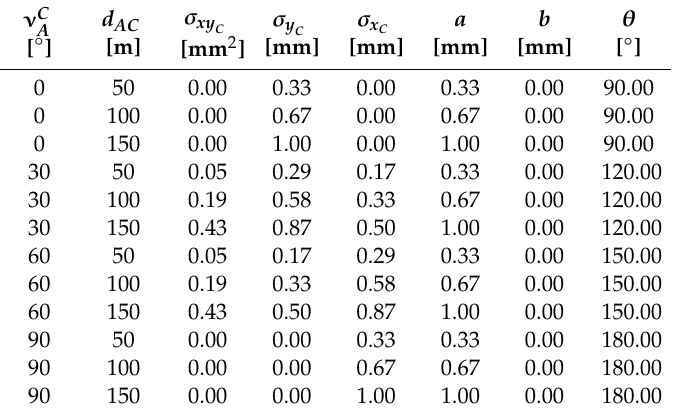
Table 1. The precision of the position of the control point 𝐶 and the elements of the standard error ellipse due to the influence of the displacement as a result of the temperature difference at orientation point 𝐵 .